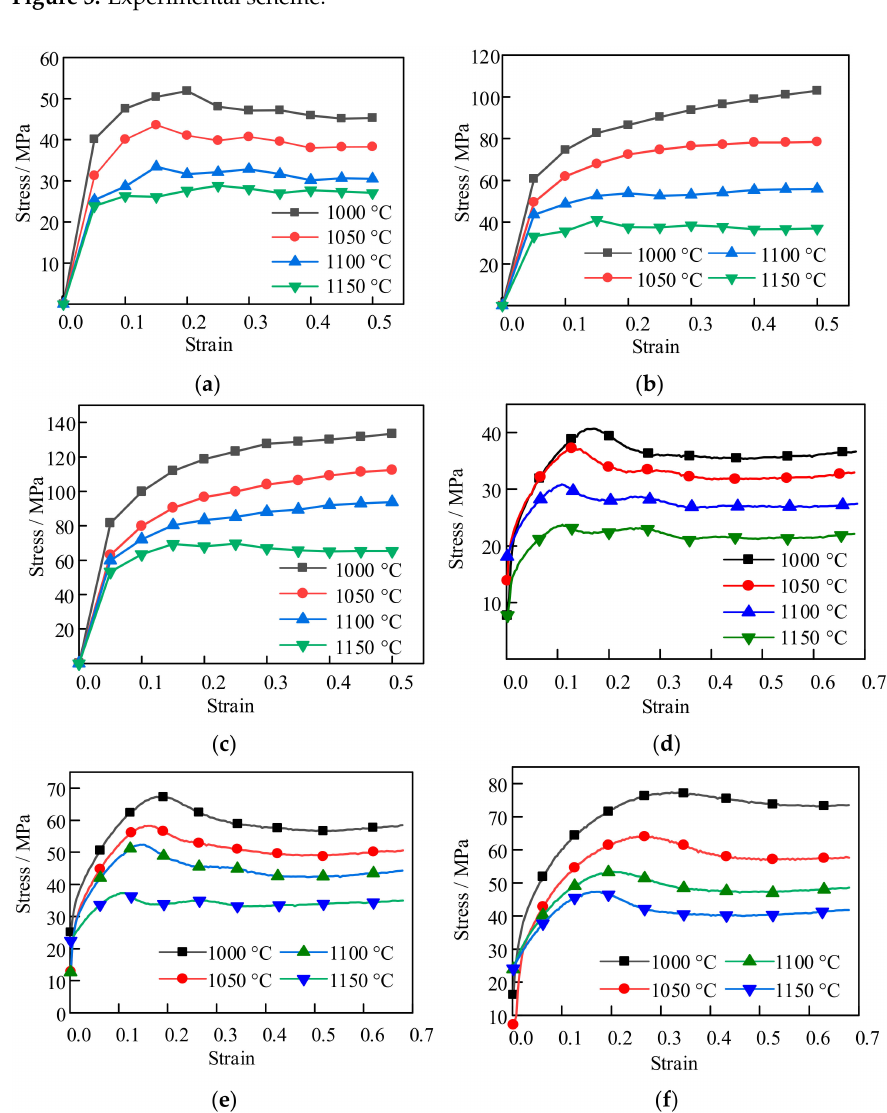
· ε = 0.001 s − 1 ; ( b ) com- · ε = 0.1 s − 1 ; ( d ) SCS at